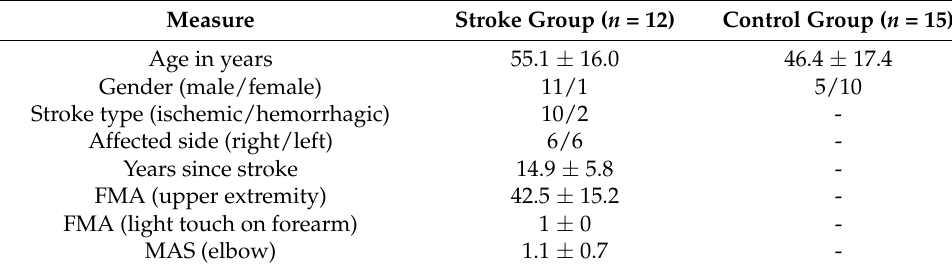
Table 1. Demographic characteristics and clinical scores of the stroke and control groups [28]. Measure Stroke Group ( n = 12) Control Group ( n = 15) Age in years 55.1 ± 16.0 46.4 ± 17.4 Gender (male/female) 11/1 5/10 Stroke type (ischemic/hemorrhagic) 10/2 - Affected side (right/left) 6/6 - Years since stroke 14.9 ± 5.8 FMA (upper extremity)